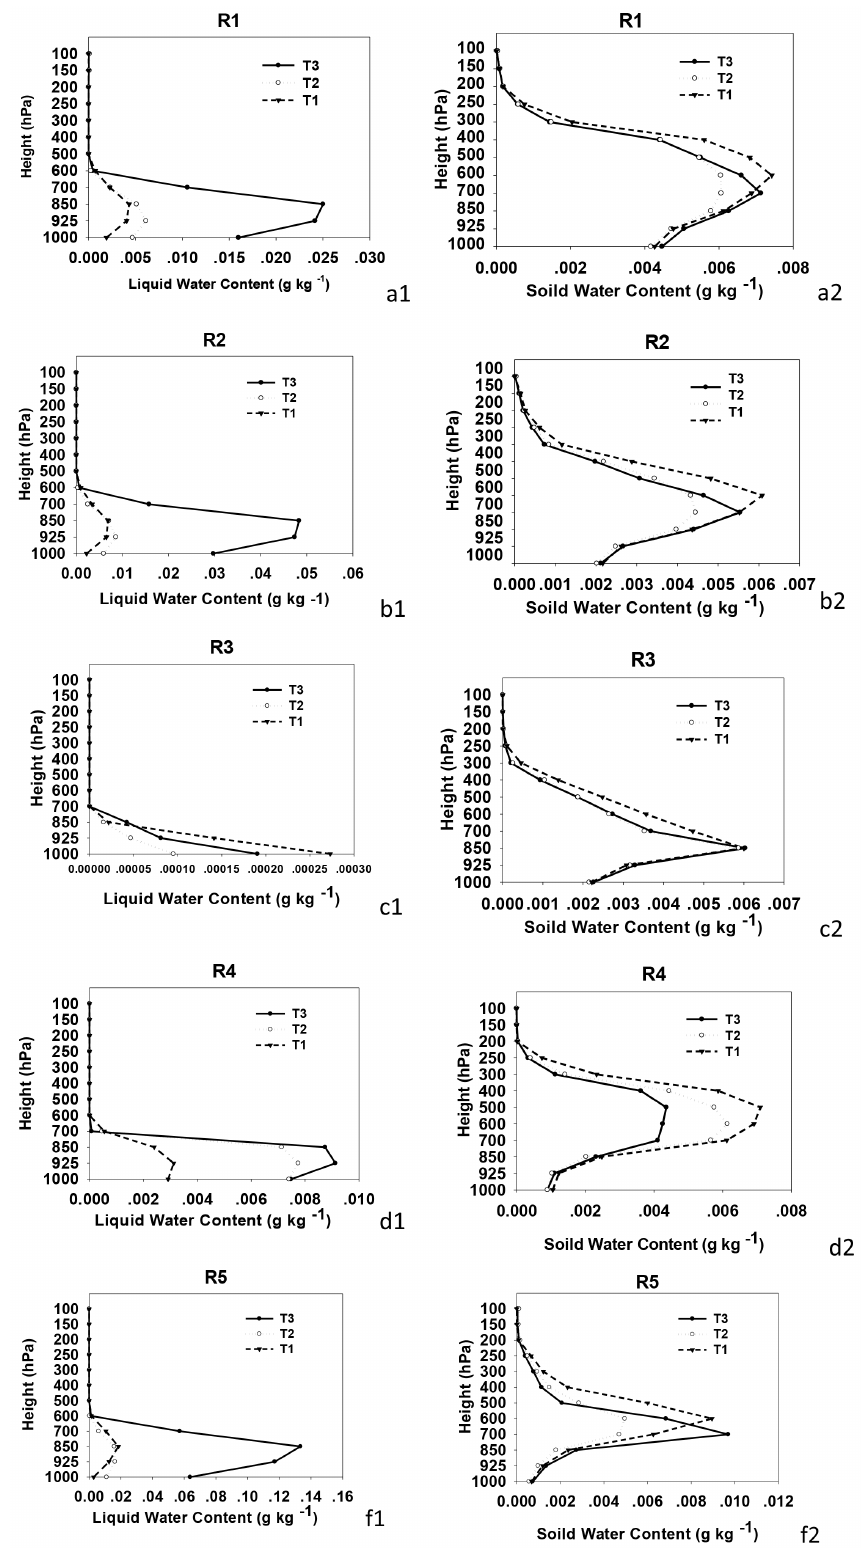
Figure 3. Vertical profiles of regional mean liquid water (a1 – f1) and solid water (a2 – f2) for R1, R2, R3, R4, and R5 from 1000 to 100hPa. T1 denotes WSM6, the control test, T2 is the WDM6 with the K2000 activation scheme, and T3 denotes WDM6 with aerosol activated from CUACE. NCEP is for NCEP